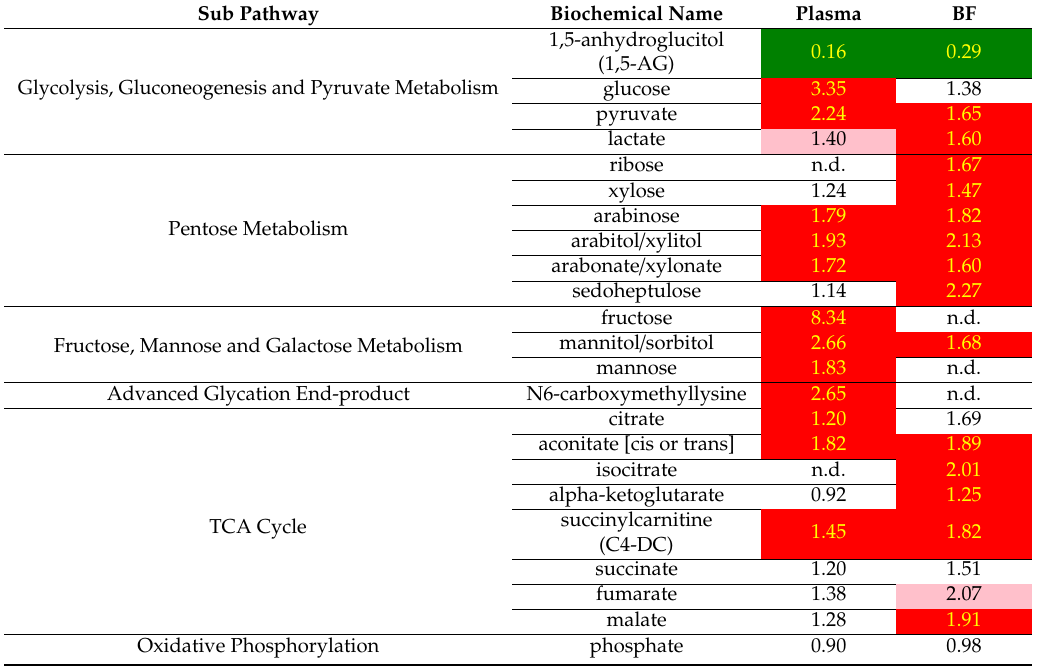
Table 2. List of selected carbohydrates and energy metabolites that were detected in maternal plasma and blastocysts cavity fluid (BF) in non-diabetic and diabetic rabbits (n.d. = not detectable). Sub Pathway Biochemical